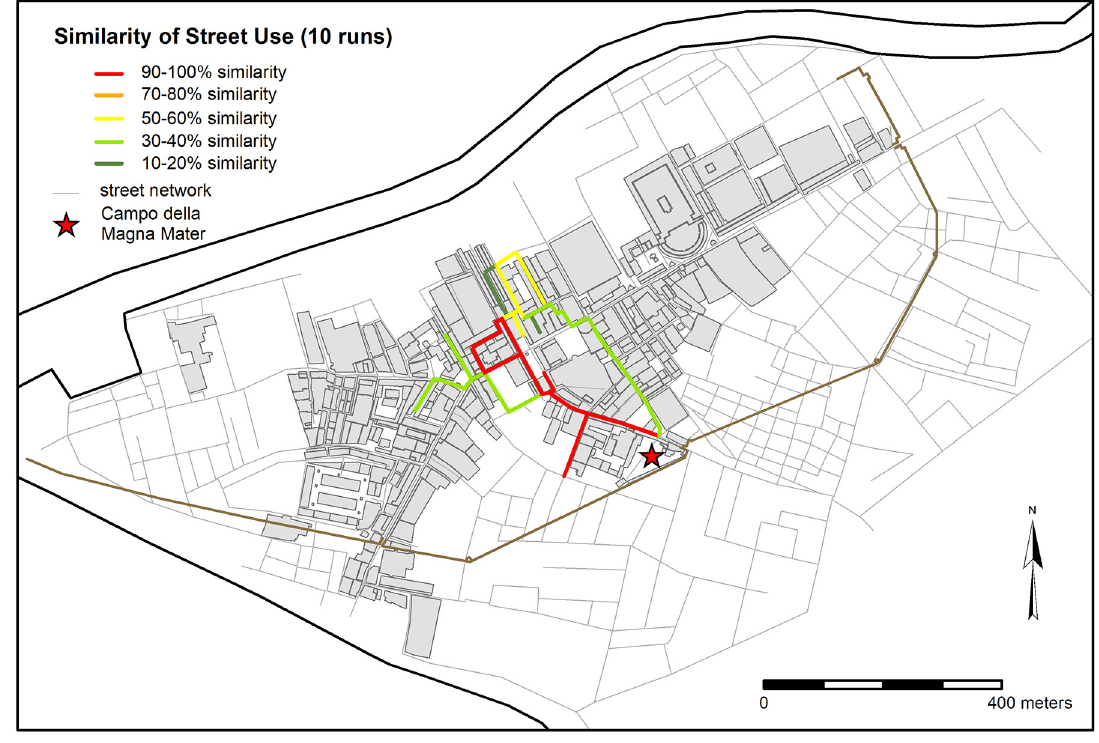
Figure 7. Map showing the similarity of street usage by un-weighted processional runs on a gradient of red to dark green. Streets shown in red are consistently used by the processional leader during almost all of the simulation runs. Streets shown in dark green are only used during 10–20% of the